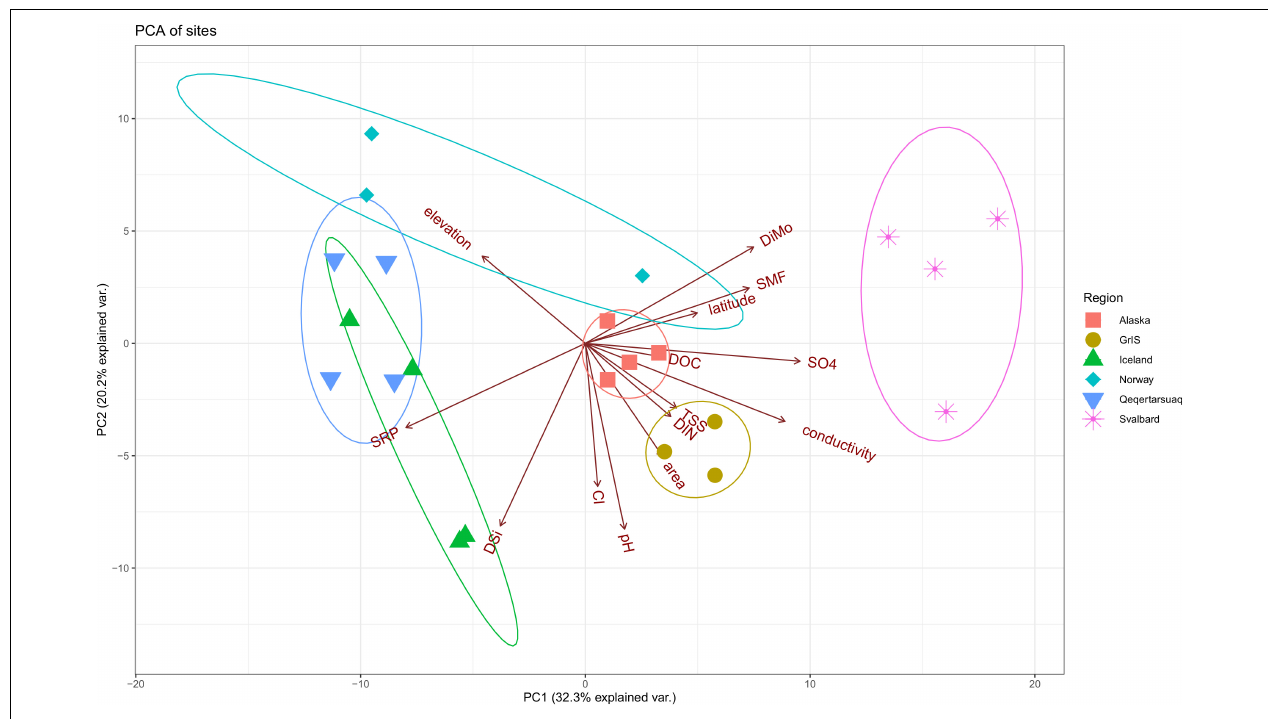
FIGURE 2 | Principle components analysis (PCA) showing differences in selected environmental variables by region. Alaska sites are shown in red squares, the Greenland Ice Sheet (GrIS) in gold circles, Iceland in green triangles, Norway in turquoise diamonds, Qeqertarsuaq in blue upside-down triangles, and Svalbard in purple asterisks. Sites with missing environmental data are excluded (i.e., Foxfonna and Midtre Lovénbreen, see Tables 1 , 2 ). Ellipse probabilities are set to